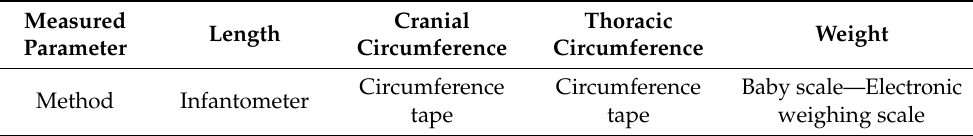
Table 1. The methods used to evaluate newborn babies. Measured